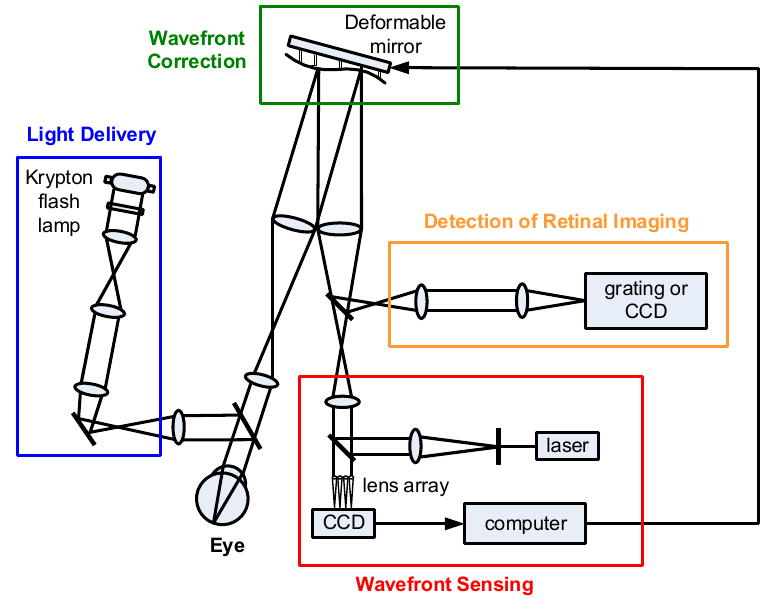
Figure 3. Simplified schematic diagram of an AO-FC optical system (Reprinted with permission from Ref. [41]. Copyright 1997, Optical Society of America).